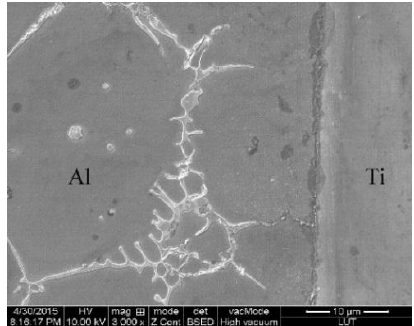
Figure 15. SEM micrographs of the Al-Ti liquid-solid interface after heating at 640 °C for 1 h and then etching by the Keller solution. Materials 2016 , 9 , 199